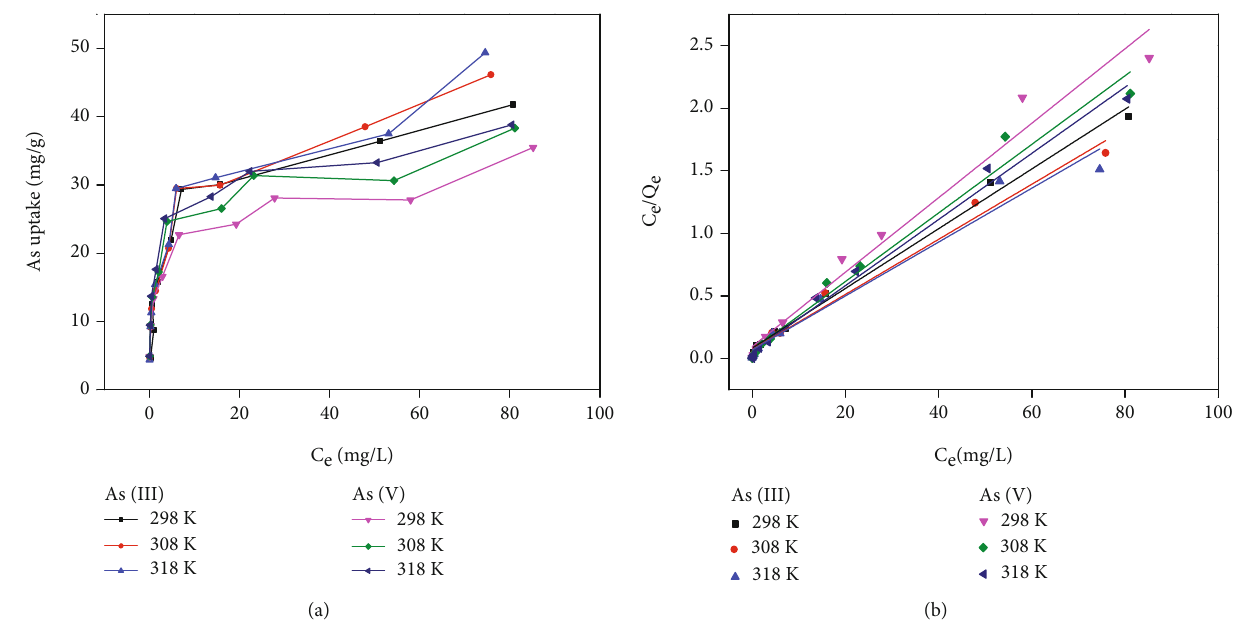
Figure 8: Adsorption isotherm for arsenic on Fe/Mn-C-LDH. Table 3: Langmuir, Freundlich, and Temkin constants for arsenic on Fe/Mn-C-LDH.